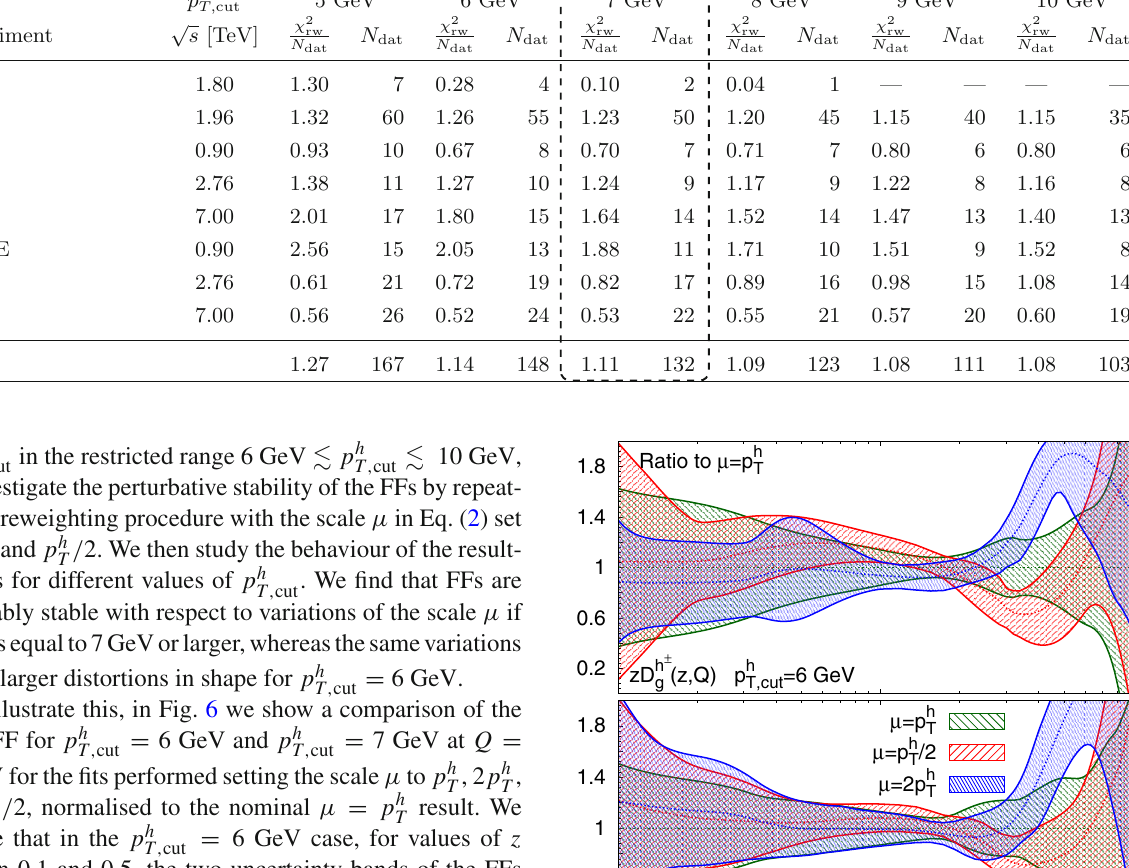
Table 2 The values of the χ 2 per data point, χ 2 rw / N dat , and the number of data points after cuts, N dat , for the pp experiments included in the fit (and their total) for a range of values of the kinematic cut p h Experiment